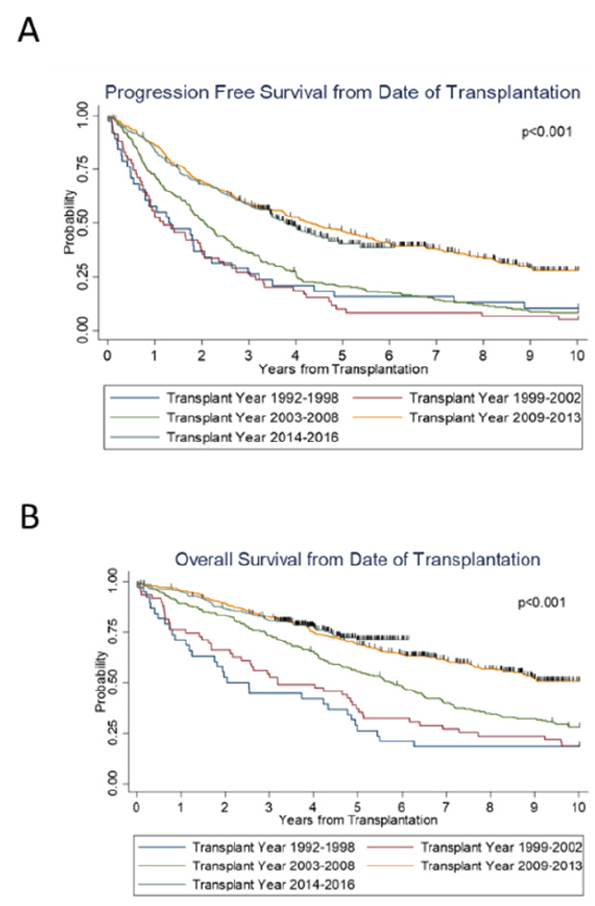
Figure 1. Survival outcomes from the time of transplantation by transplant years. Notably, for both groups 4 and 5, the median OS was not reached (NR). The median PFS was about 4 years for these groups. Group 3 was the most recent to reach a median OS, which was 5.8 years (95% CI 4.8–6.5 years). From the time of diagnosis, both PFS ( p < 0.001) and OS ( p < 0.001) significantly improved over the years.